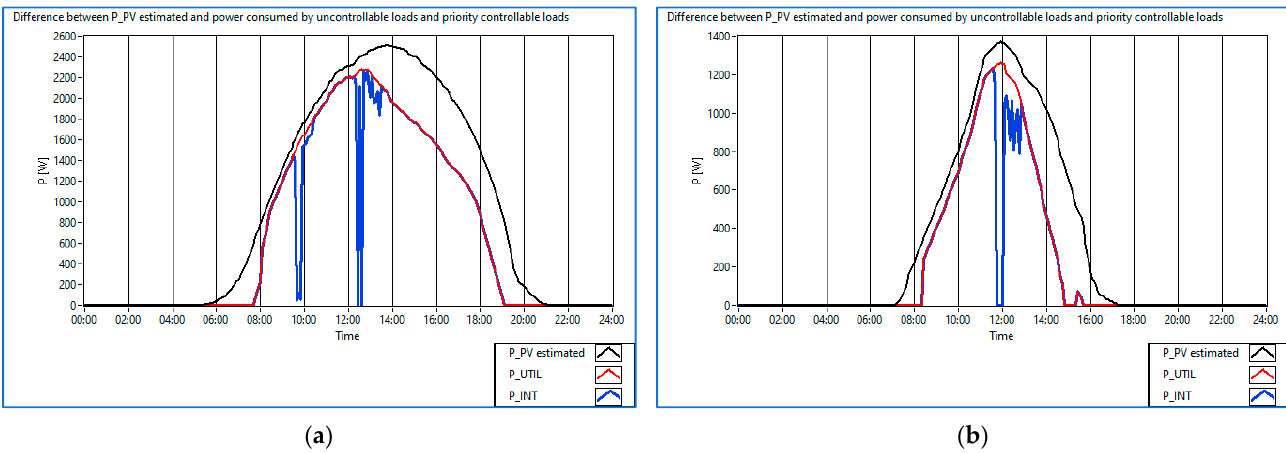
Figure 9. P PV estimated by RBF, P UTIL , P INT for ( a ) scenario 1; ( b ) scenario 2.